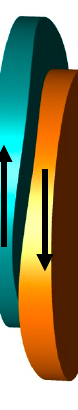
Figure 2. Alvarez-Humphrey optics. Variation of the refraction power by means of a shift of the Alvarez-Humphrey surfaces perpendicular to the optical axis ( z -axis in the figure).